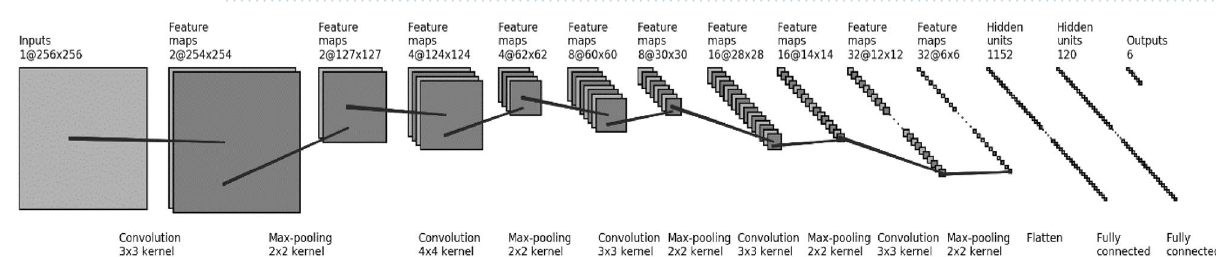
Figure 2. Schematic plot of the NN of the ML model including convolutional layer, pooling layer, and fully connected